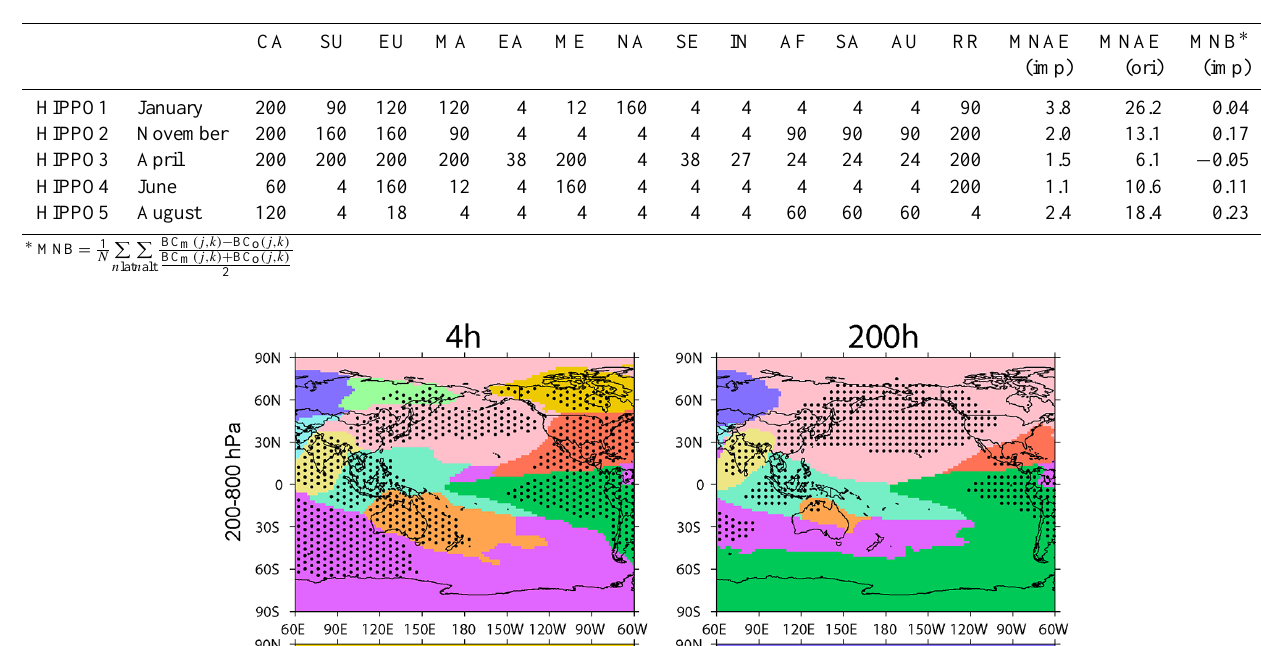
Table 1. Best-fit aging timescales for 13 regional BC tracers (units: hours), the mean normalized absolute error (MNAE) for the improved model (imp) and the original model (ori), and the mean normalized bias (MNB) for the improved model compared to the vertical profiles measured by HIPPO.